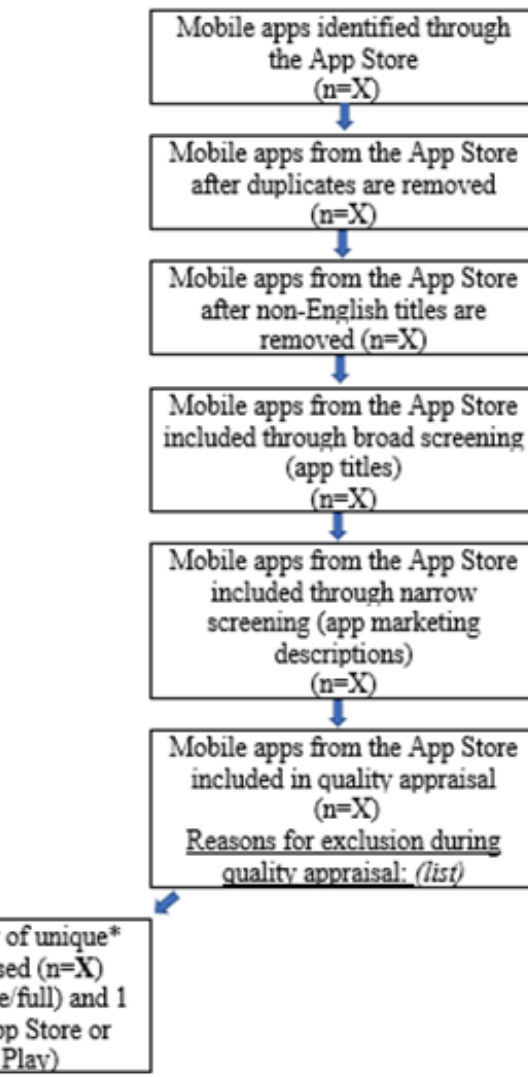
Figure 2. Search and selection